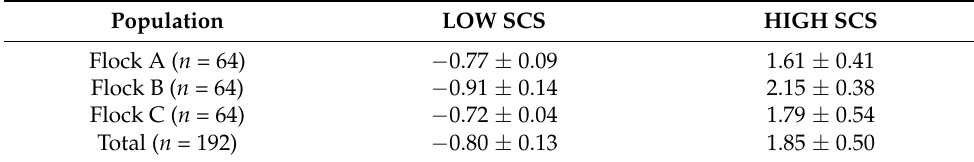
Table 1. Corrected phenotype estimates mean values and standard deviation for the somatic cell score (SCS) trait for the animals selected for the genome-wide association study (GWAS) within high and low SCS tails. The ewes selected for these groups were in the highest 10% and lowest 14% tails of the distribution of estimated corrected phenotypes obtained for all ewes ( n = 1894).